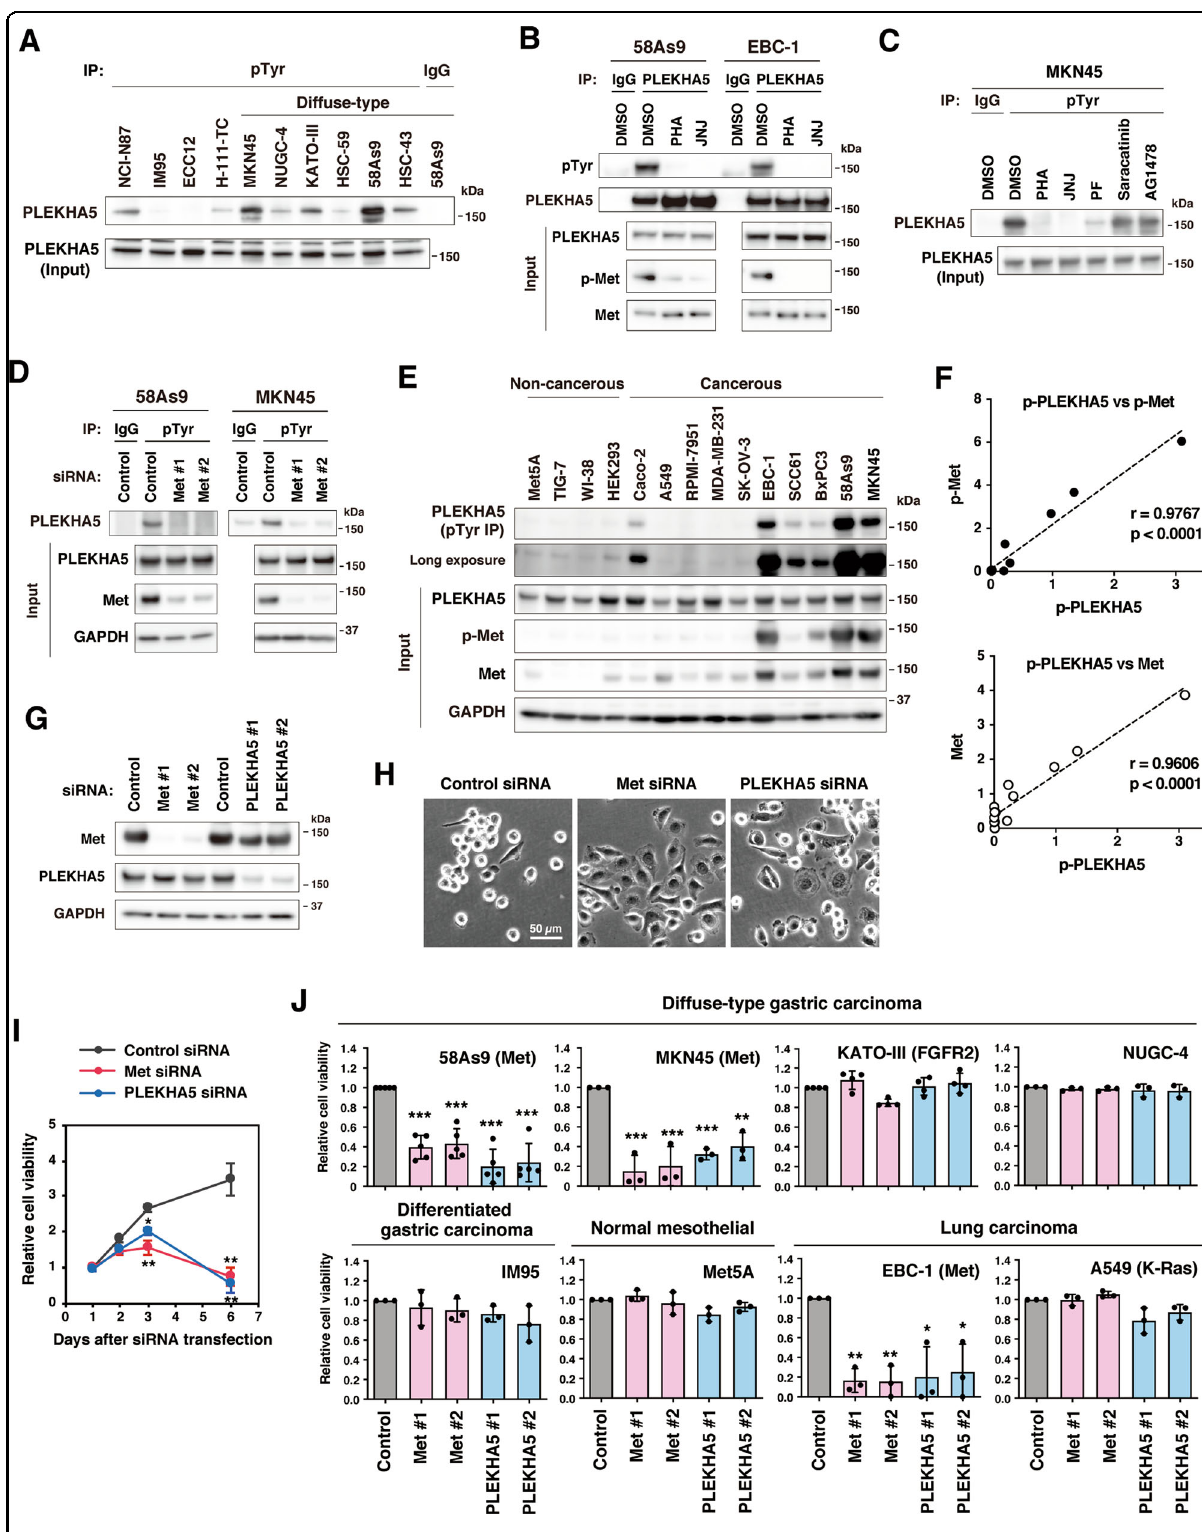
Fig. 1 (See legend on next